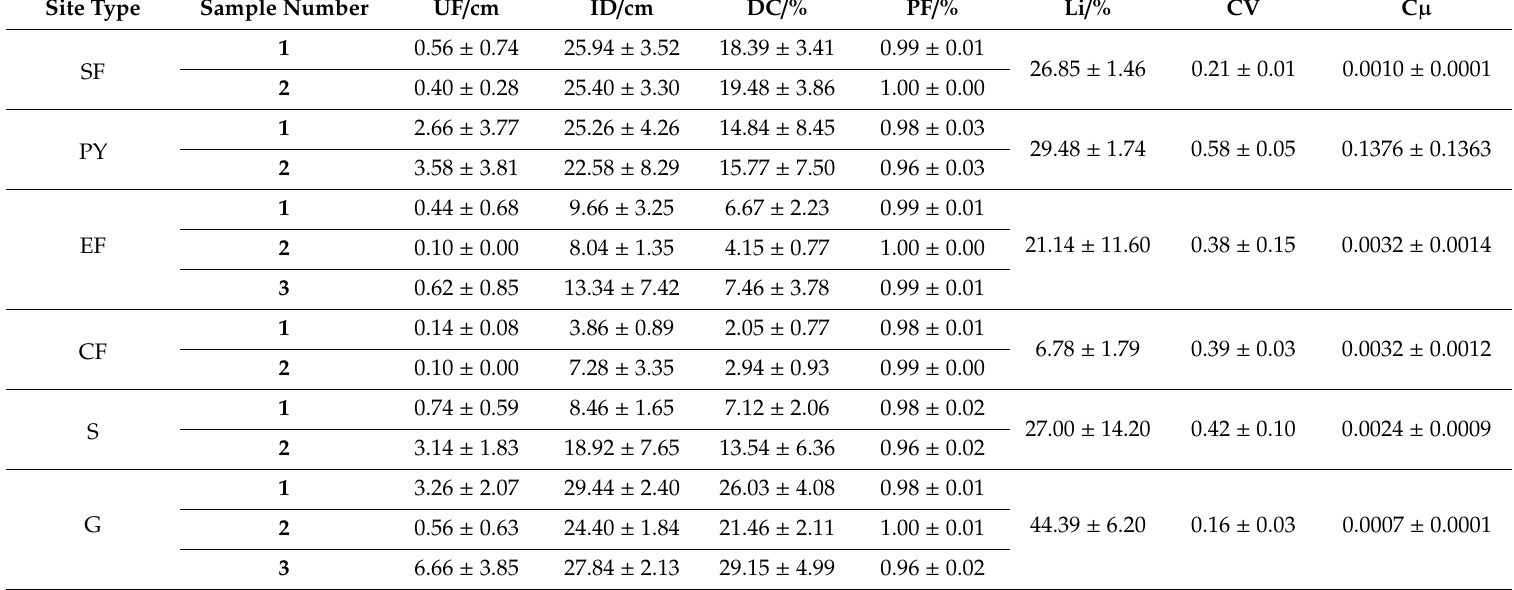
Table 5. Characteristic parameters of preferential flow variables. (G55). (average value ± standard deviation).